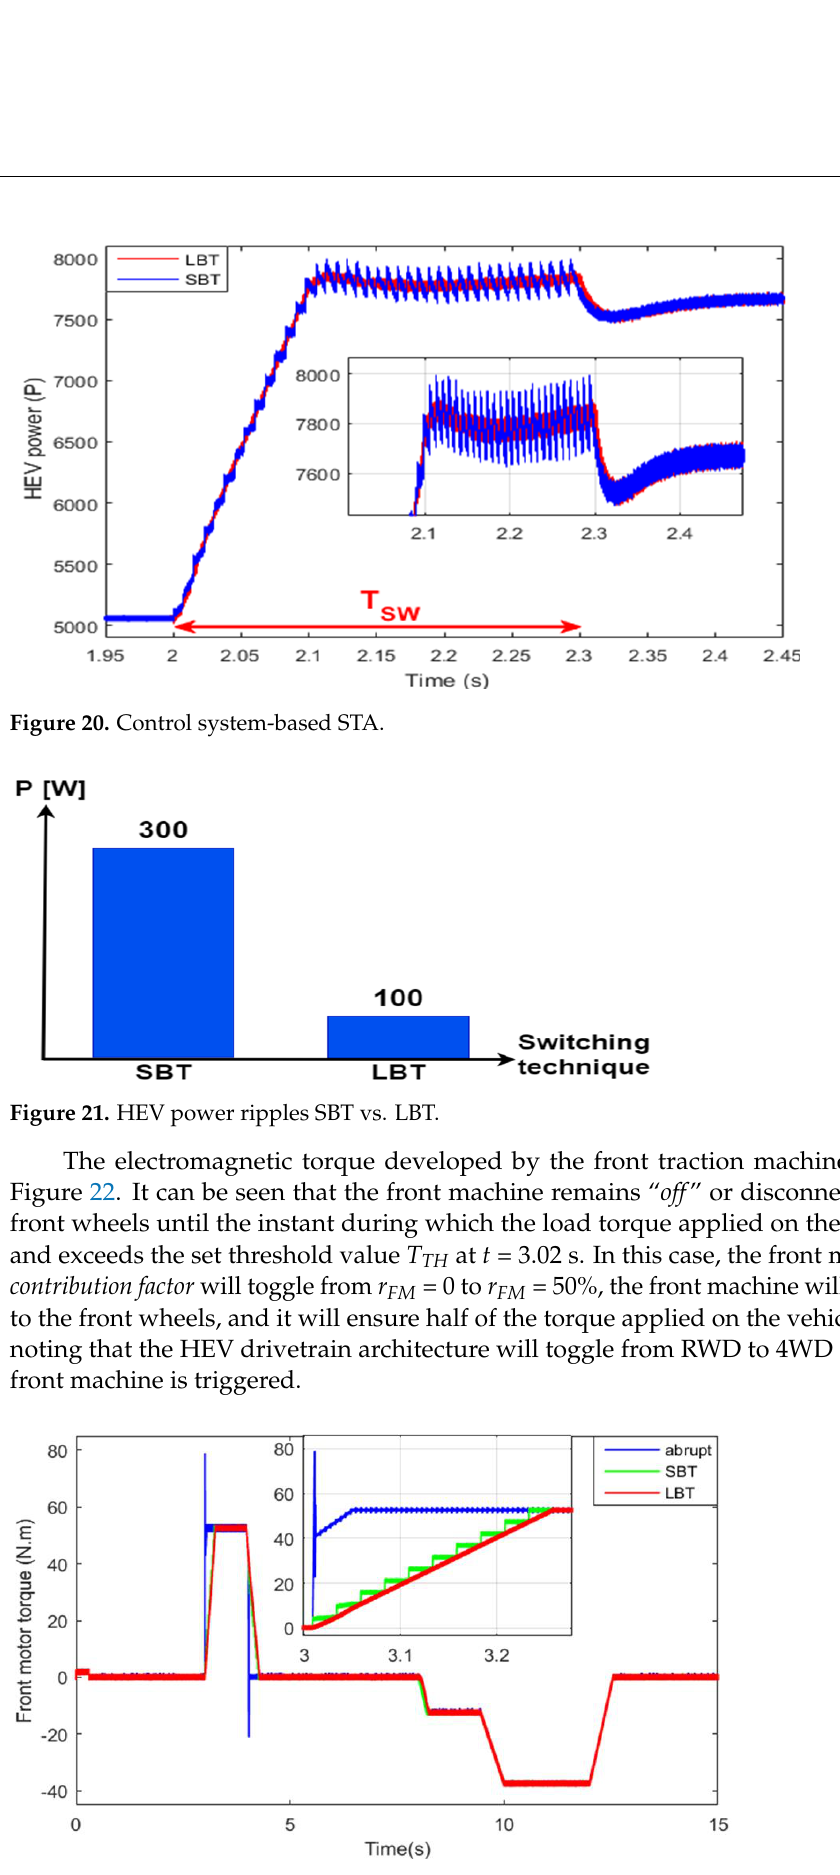
Figure 22. Front motor torque.